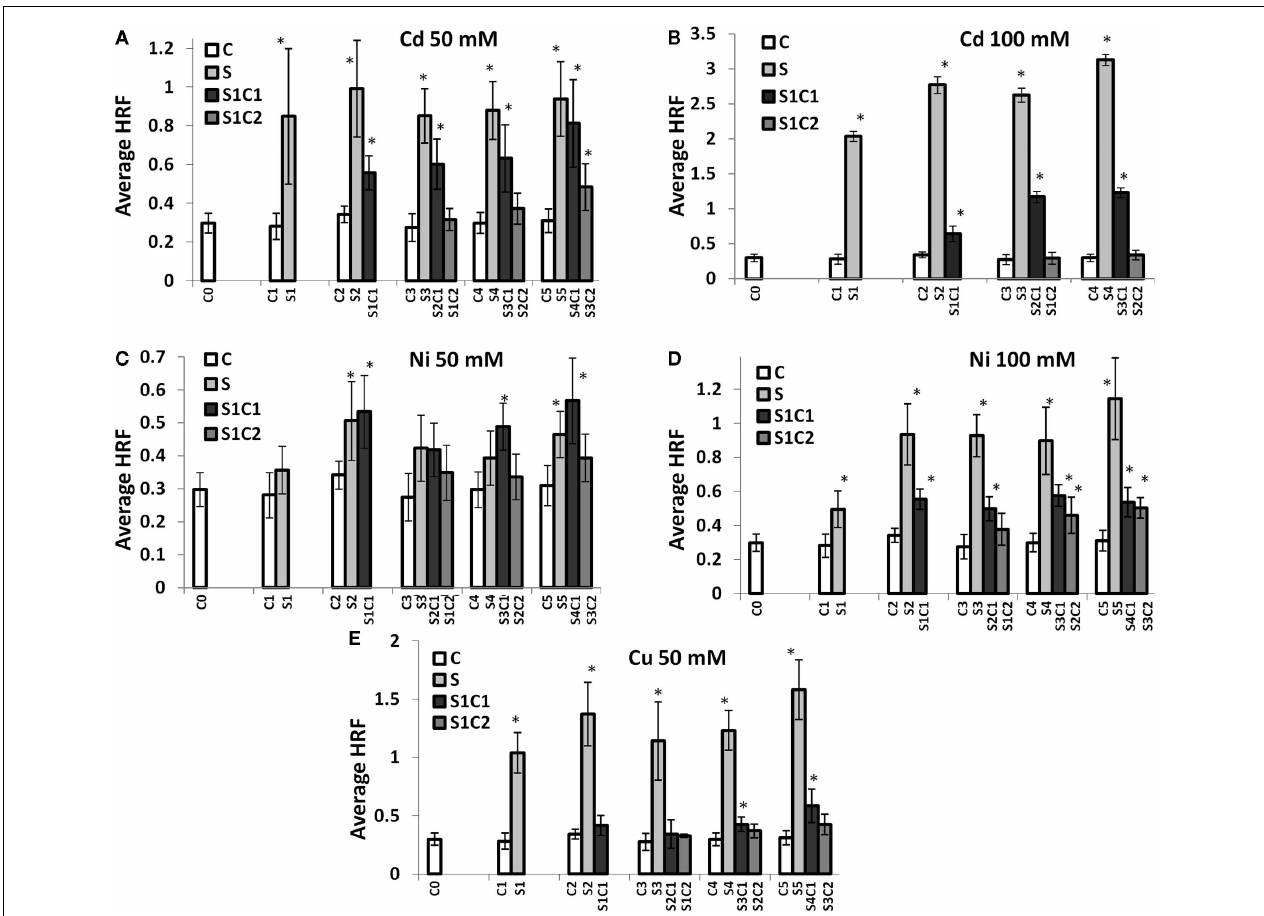
plants (ct), exposed plants (S), and plants exposed in the G0 and non-exposed in the G1 (S_Ct1). “G3–G5” shows the third, fourth, and fifth generations of control plants (ct), exposed plants (S), plants exposed to stress followed by growth in control conditions for one generation (S_Ct1) or two generations (S_Ct2). Asterisks indicate when there is a significant difference between the individual group of progeny of stressed and the corresponding progeny of control plants (Student’s t -test, p < 0.05 in all cases). No significant difference among the progeny of control (G0–G5) plants was found (Single factor ANOVA, p >